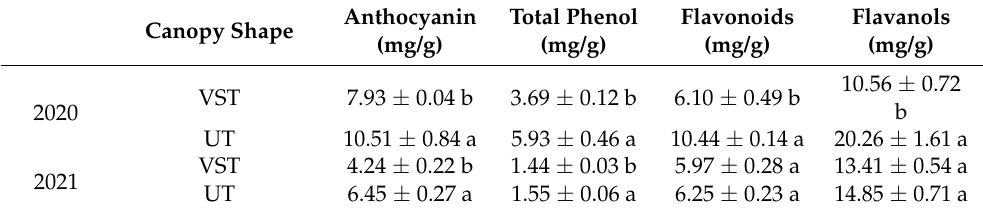
Table 3. Effect of canopy types on the secondary metabolite of grape berries. Canopy